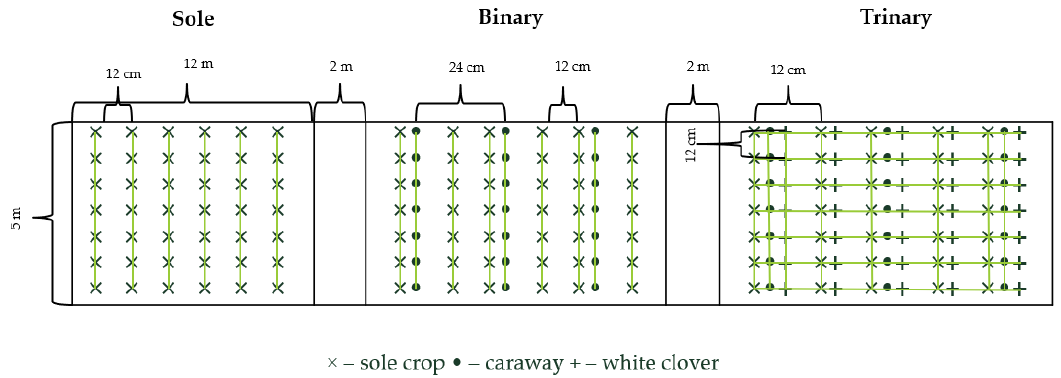
Figure 2. Sowing arrangement for the multi-cropping experiment.